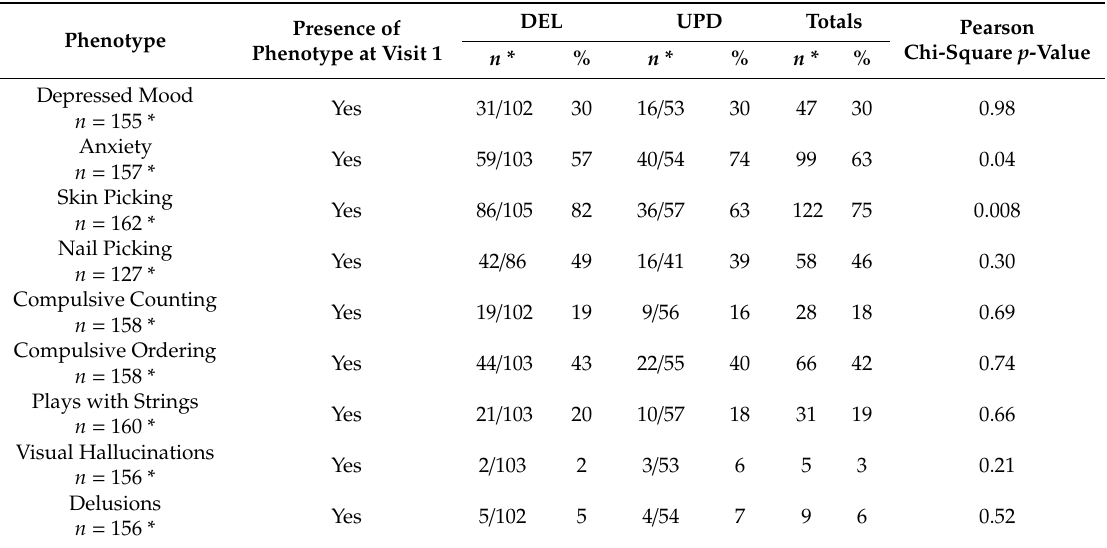
Table 2. Presence of psychiatric phenotypes by deletion (DEL) and uniparental disomy (UPD) subtypes.